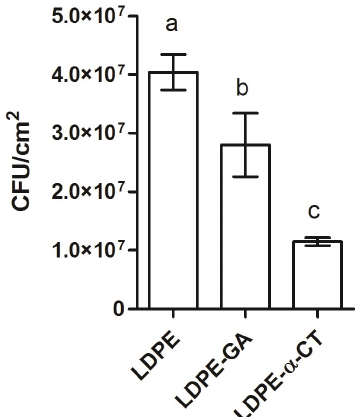
Figure 1. Biomass within the biofilm grown on non-functionalized (low-density polyethylene (LDPE) and LDPE-glutaraldehyde (GA)) and functionalized polyethylene surfaces (LDPE-α-chymotrypsin (α-CT)) by plate count viability assay. Data represent the mean ± standard deviation of four independent measurements. Letters a, b and c indicate significant differences (Tukey’s honest significant different (HSD) test, p ≤ 0.05) between the means of different surfaces.